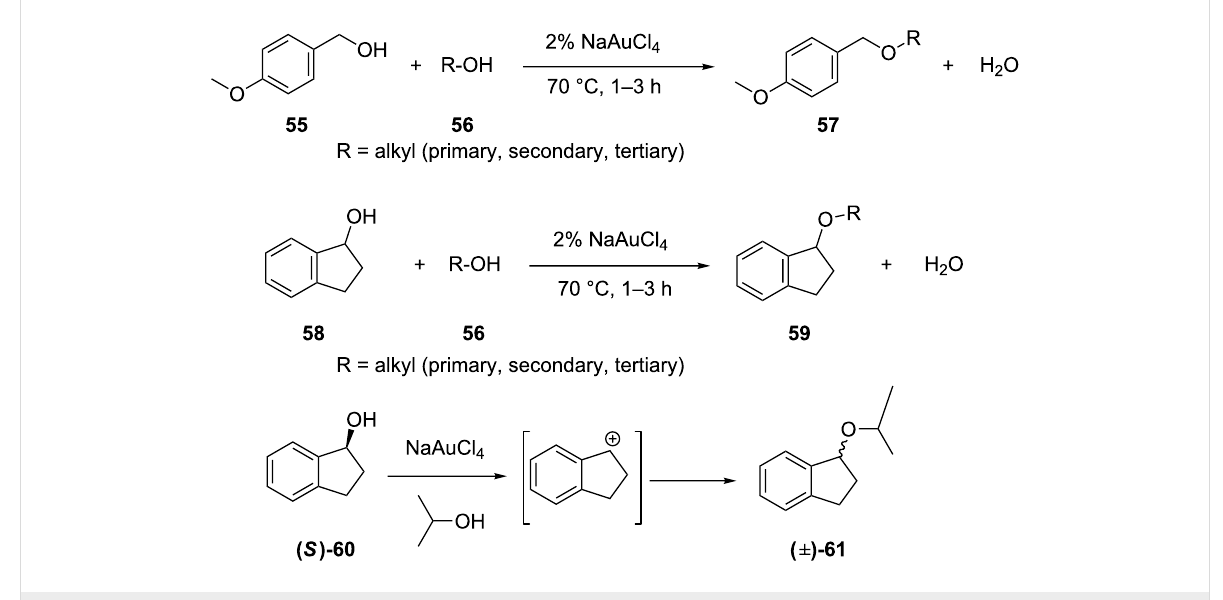
Scheme 11: Preparation of unsymmetrical ethers from alcohols.